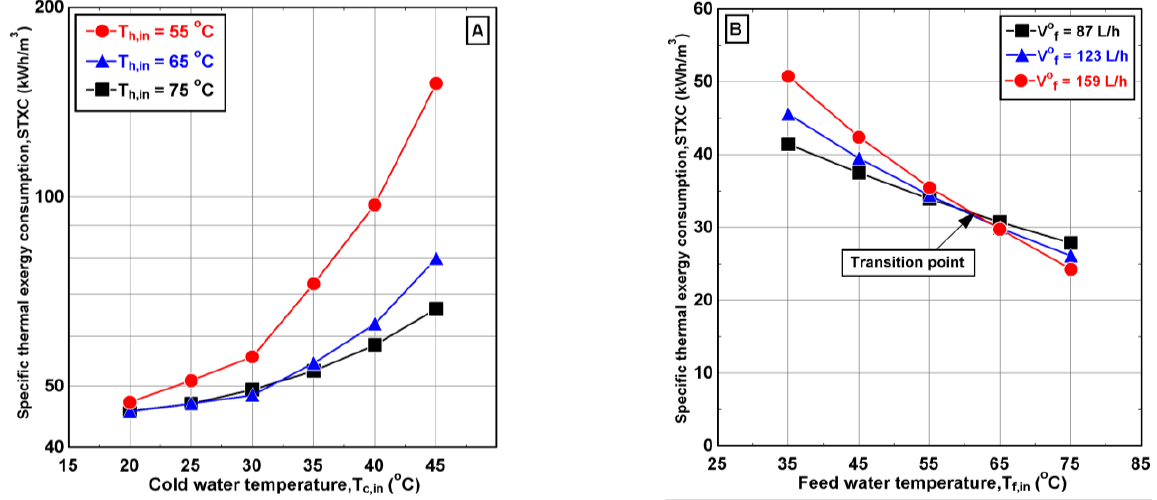
Figure 12. Variation of the specific thermal exergy consumption (STXC) with ( A ) inlet cold water temperature for different inlet hot water temperatures, and ( B ) feed water temperature for different feed water flow rates ( 𝑉̇ ℎ = 840 L/h, 𝑉̇ 𝑐 = 405 L/h, w = 1260 ppm, and P a , vac = 115 mbar).